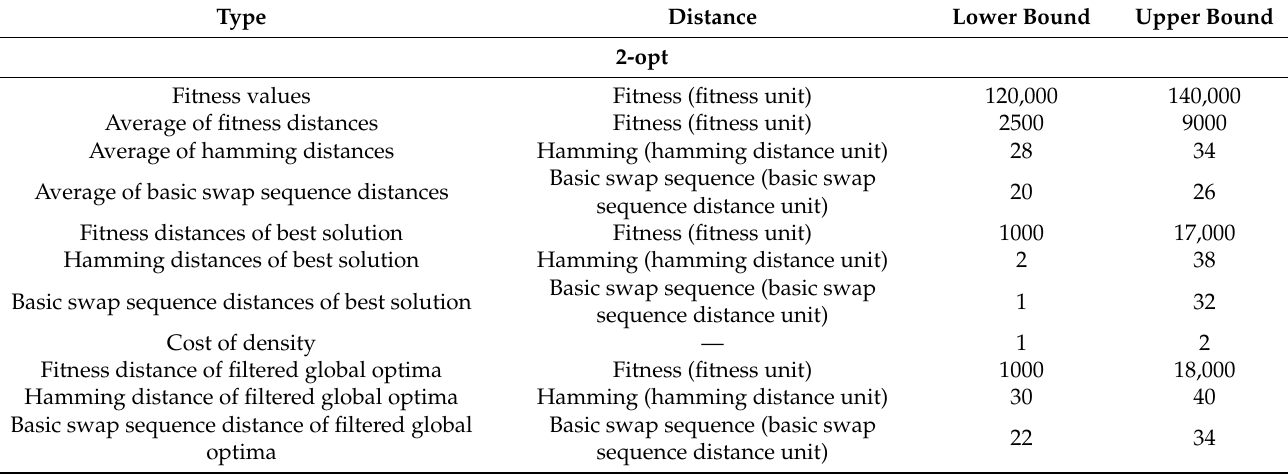
Table 4. The summary of the results of the random walk where the solutions are compared to each